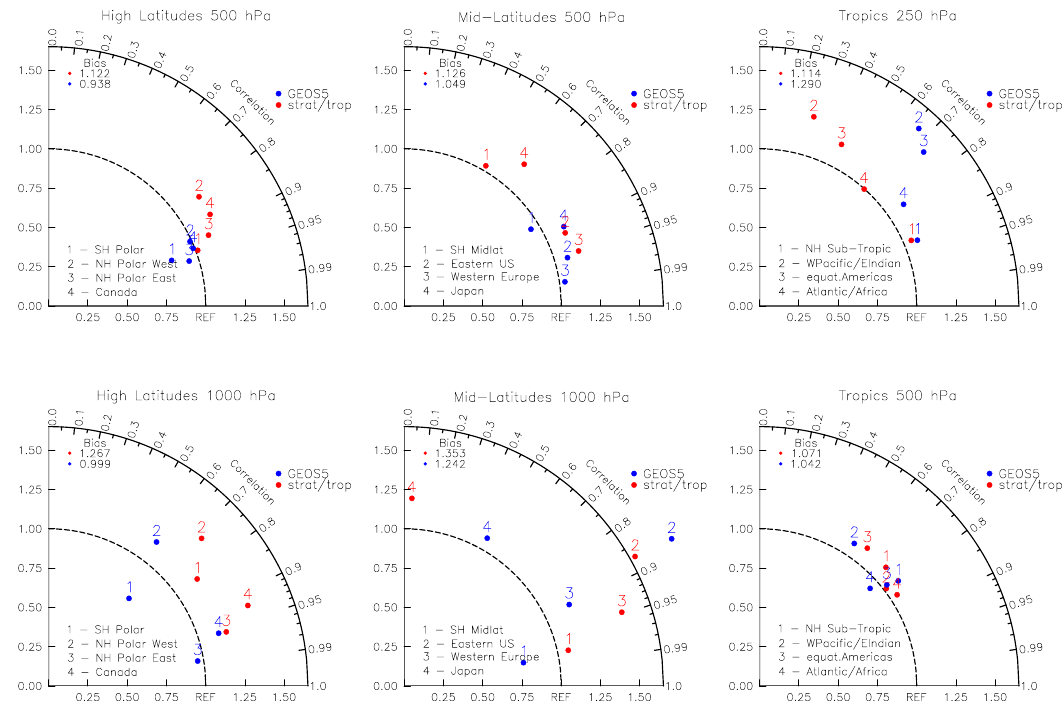
Fig. 14. Taylor diagram for regions in high latitudes (left), mid-latitudes (middle), and the Tropics (right) for two different altitude levels in the troposphere. The two model simulations, CAMChem strat/trop (red) and CAMChem GEOS5 (blue) are compared to the ozone climatology. The x-axis shows the relative ozone bias of the simulations compared to the observations, whereas the radiant describes the correlation coefficient of seasonal averaged ozone values between simulated and observed values. Numbers symbolize different